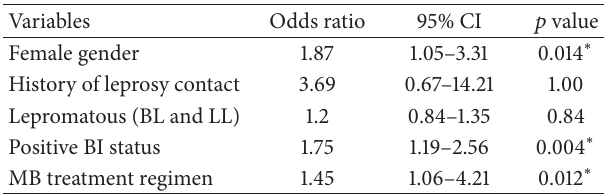
Table 4: Multivariate